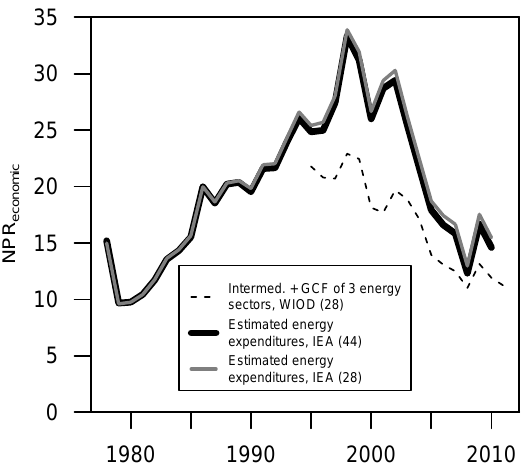
The trends are similar for both the economic-based net power ratio of the world economy calculated as NPR economic = f − 1 using IEA data in this paper and e ,GDP NPR economic,WIOD = GDP/(intermediate energy sector spending), assuming the three WIOD energy sectors intermediate (“Intermed”) spending. WIOD = uses data in World Input Output Database; IEA = uses IEA data as calculated in this manuscript; 44 = calculations include data from all 44 countries in our IEA dataset; and 28 = calculations include only 28 countries in both WIOD and IEA